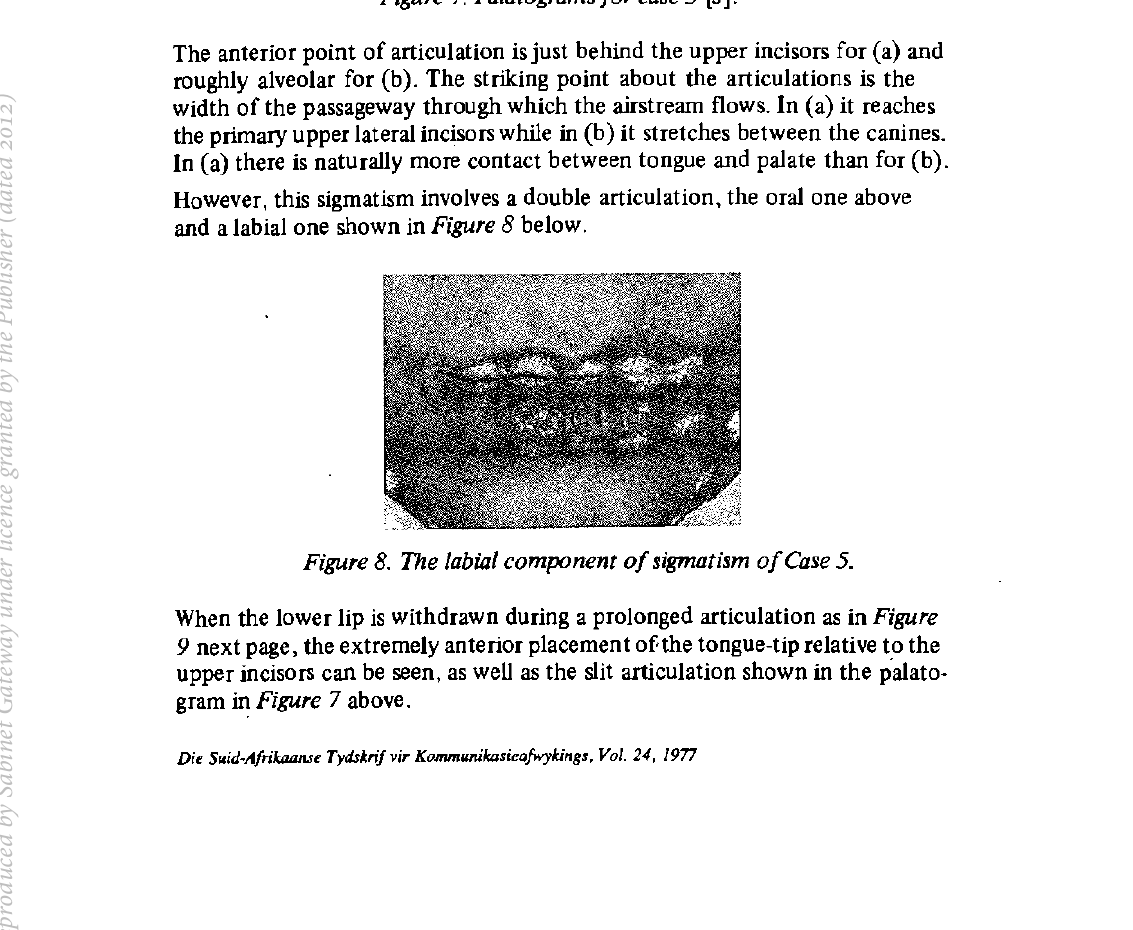
Figure 7. Palatograms for case 5 [s].